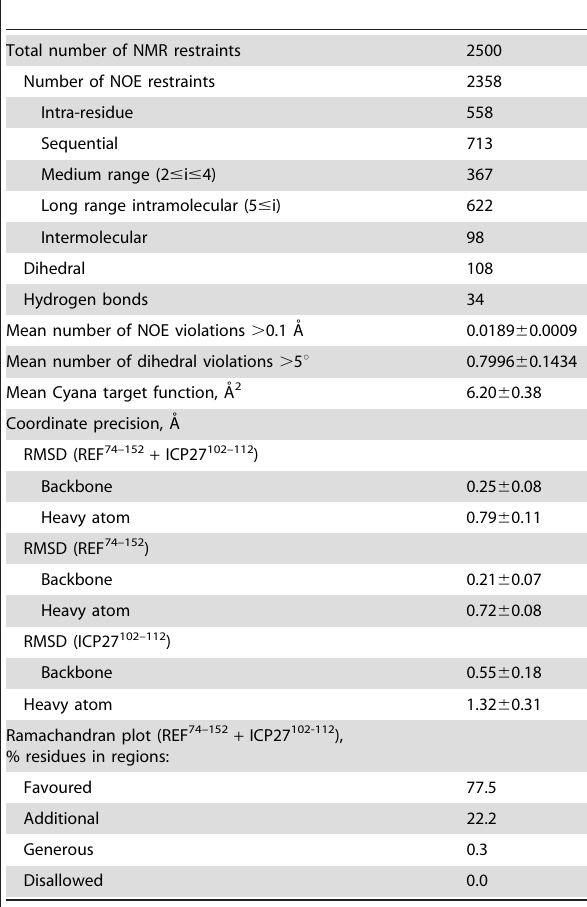
Table 1. NMR calculation statistics for an ensemble of the 20 lowest energy structures of REF 54–155 bound to ICP27 103–138